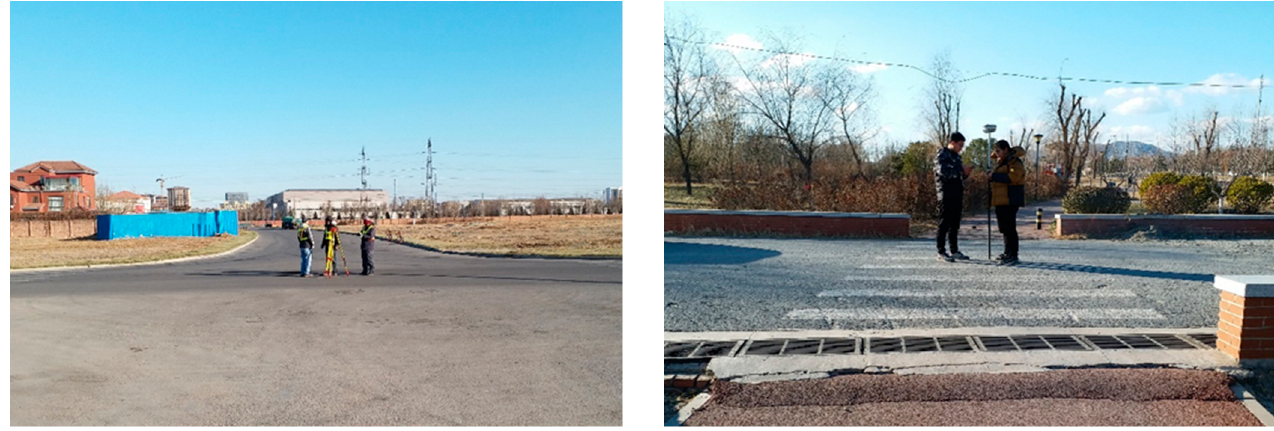
Figure 4. Field photos of surveying GPS control points. Table 2. Classification of longitude and